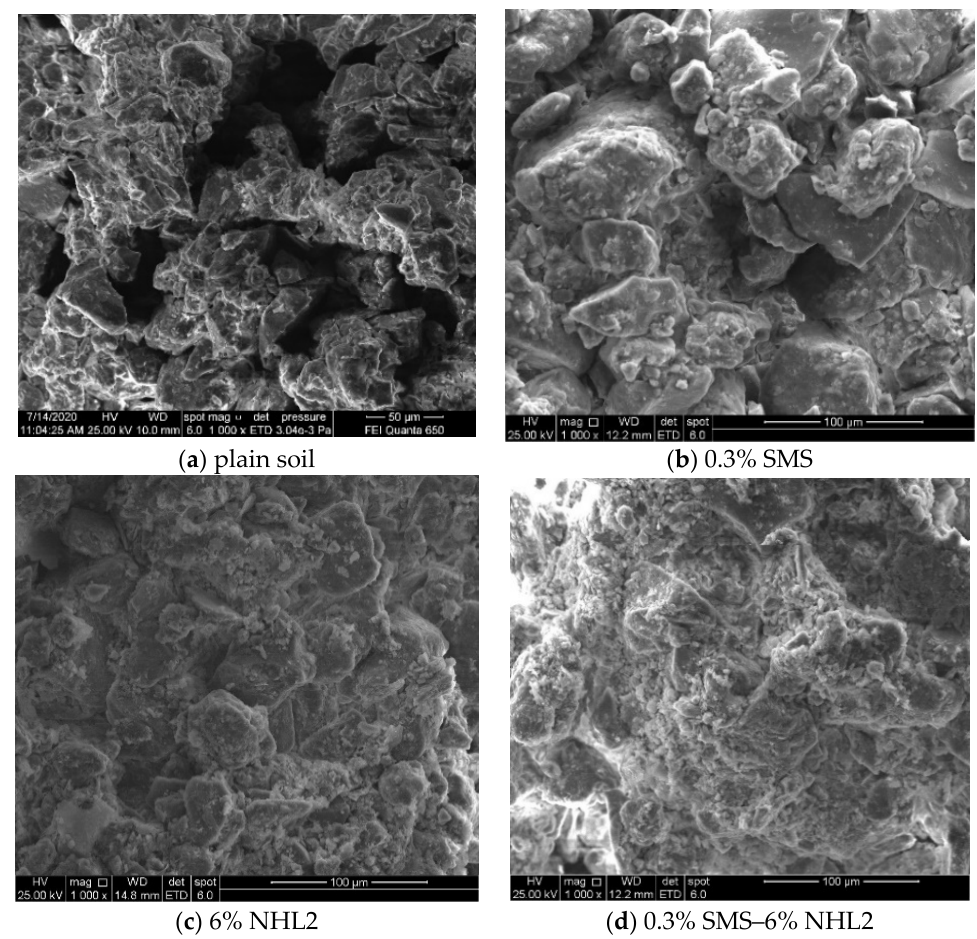
Figure 12. Photo of microstructure with different